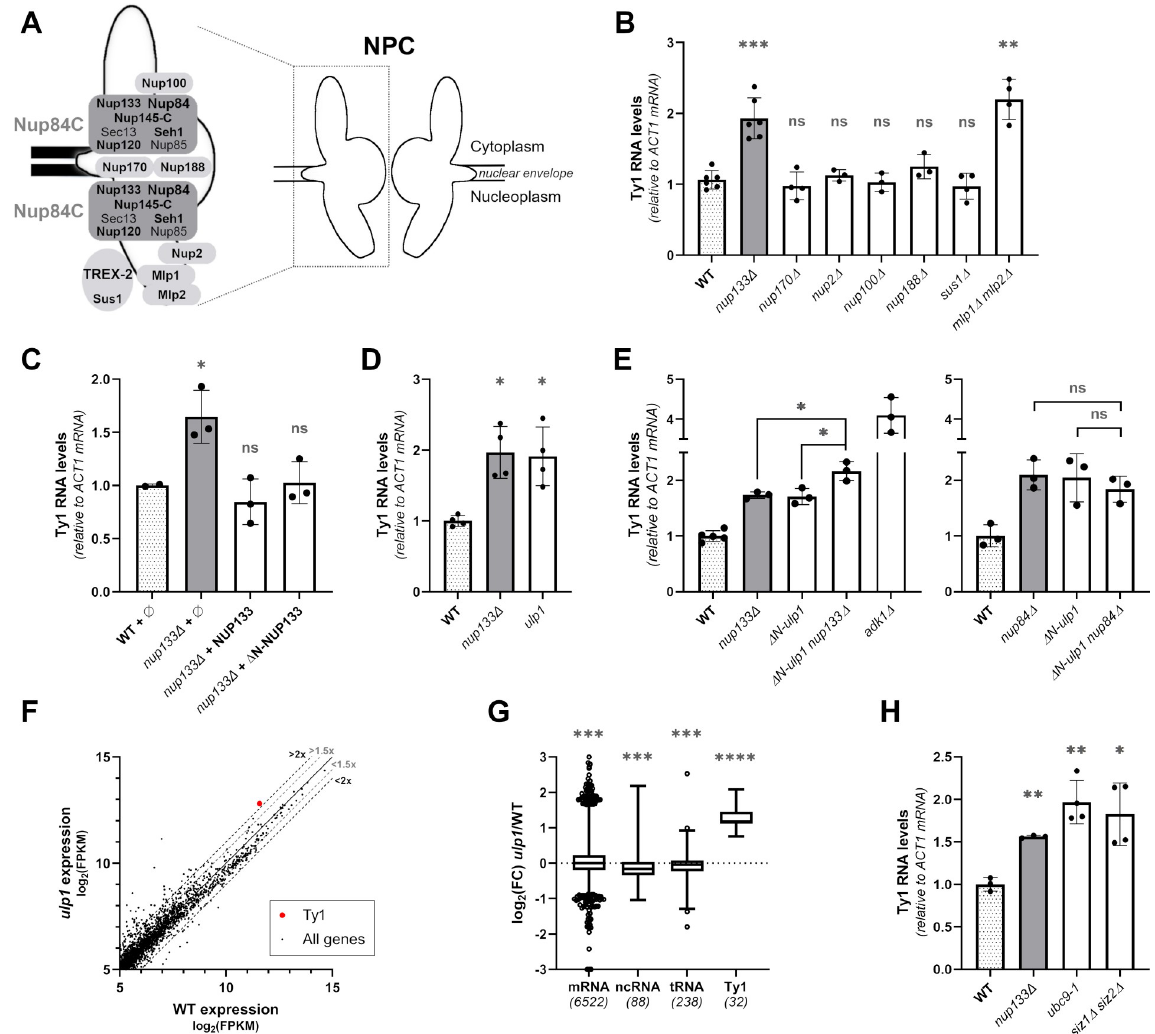
Fig 3. The Nup84 complex represses Ty1 expression through the tethering of the SUMO protease Ulp1 at the NPC. (A) Schematic representation of the structural organization of the NPC, highlighting the relative position of the nucleoporins analyzed in this study. Nup84 complex (Nup84C) subunits and other nucleoporins mutated here appear in bold. (B) Ty1 RNA levels in WT cells and mutants of nucleoporins and NPC-associated proteins, as measured by RT-qPCR (mean ± SD, n � 3, relative to WT and normalized to ACT1 mRNAs). Ty1 RNA levels in the nup133 Δ mutant are shown as a control of Ty1 induction. (C) Ty1 RNA levels in nup133 Δ cells carrying either the pUN100 ( ø ), the pUN100-protA-NUP133 or the pUN100-protA- Δ N-NUP133 plasmids, as measured by RT-qPCR (mean ± SD, n � 2, relative to WT and normalized to ACT1 mRNA values). (D) Ty1 RNA levels in WT cells and the ulp1 mutant, as measured by RT-qPCR (mean ± SD, n � 3, relative to WT and normalized to ACT1 mRNAs). Ty1 RNA levels in the nup133 Δ mutant are shown as a control of Ty1 induction (same values as panel B). (E) Ty1 RNA levels in WT cells and single or double nup133 Δ Δ N-ulp1 or nup84 Δ Δ N-ulp1 mutants, as measured by RT-qPCR (mean ± SD, n � 3, relative to WT and normalized to ACT1 mRNA). The adk1 Δ mutant was used as a characterized Ty1 RNA-accumulating control mutant, in which up-regulation of the Tye7 transcription factor leads to enhanced Ty1 expression [72]. (F) Scatterplot showing expression levels of cellular RNAs in ulp1 mutants vs WT cells as described in Fig 1B. The abundance of total Ty1 RNAs is highlighted with a red dot. The thresholds of 1.5 or 2-fold change between the 2 strains are indicated by a grey or dark dashed line, respectively. (G) Boxplot analysis of log 2 fold change (FC) of different categories of transcripts in ulp1 mutant relative to WT cells. The number of transcripts expressed in both strains and considered in each category is indicated in brackets. Only reads assigned to a single locus in the genome were considered for this analysis. (H) Ty1 RNA levels in WT cells and ubc9-1 or siz1 Δ siz2 Δ mutants, as measured by RT-qPCR (mean ± SD, n � 3, relative to WT and normalized to ACT1 mRNAs). ns, not significant; � p < 0.05; �� p < 0.01; ��� p < 0.001, ���� p < 0.0001, Welch’s t test with comparison to WT (B,C,D,H) or as indicated (E), or two-sided Wilcoxon rank-sum test